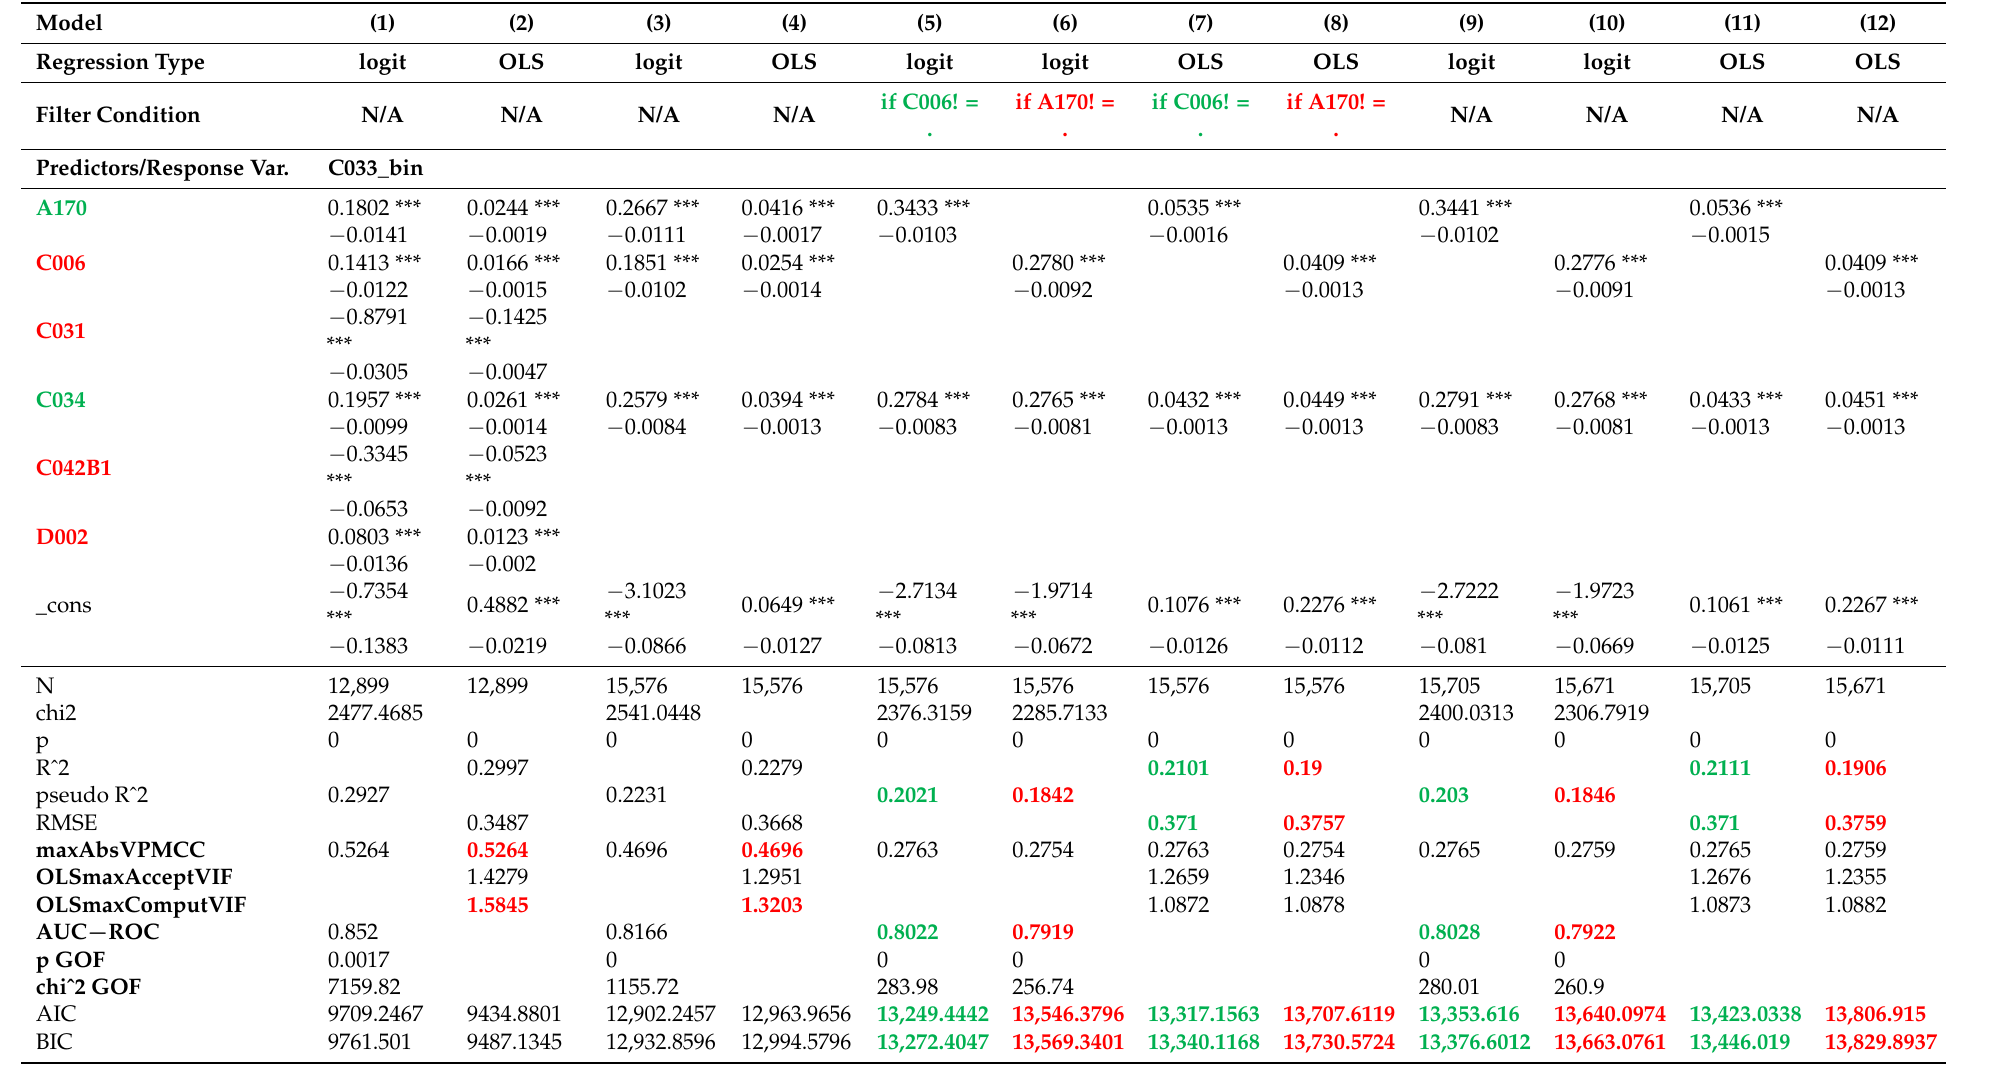
Table A5. Comparative models for predicting job satisfaction (C033_bin) after removing reverse causality and collinearity issues and performing additional